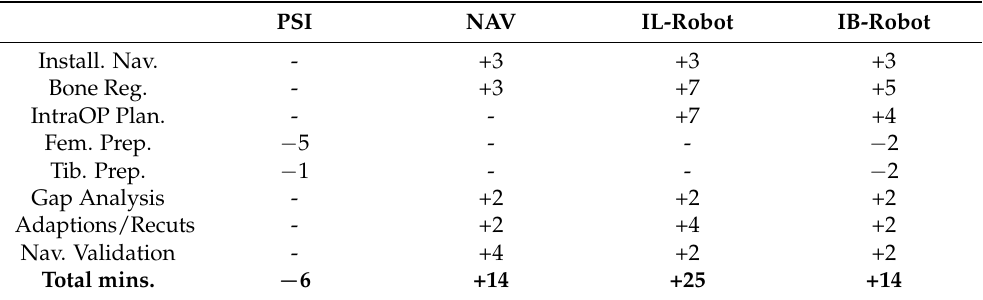
Table 1. Tabular representation of the differences in the intraoperative workflows for each investigated technology, as compared to conventional standard procedure.